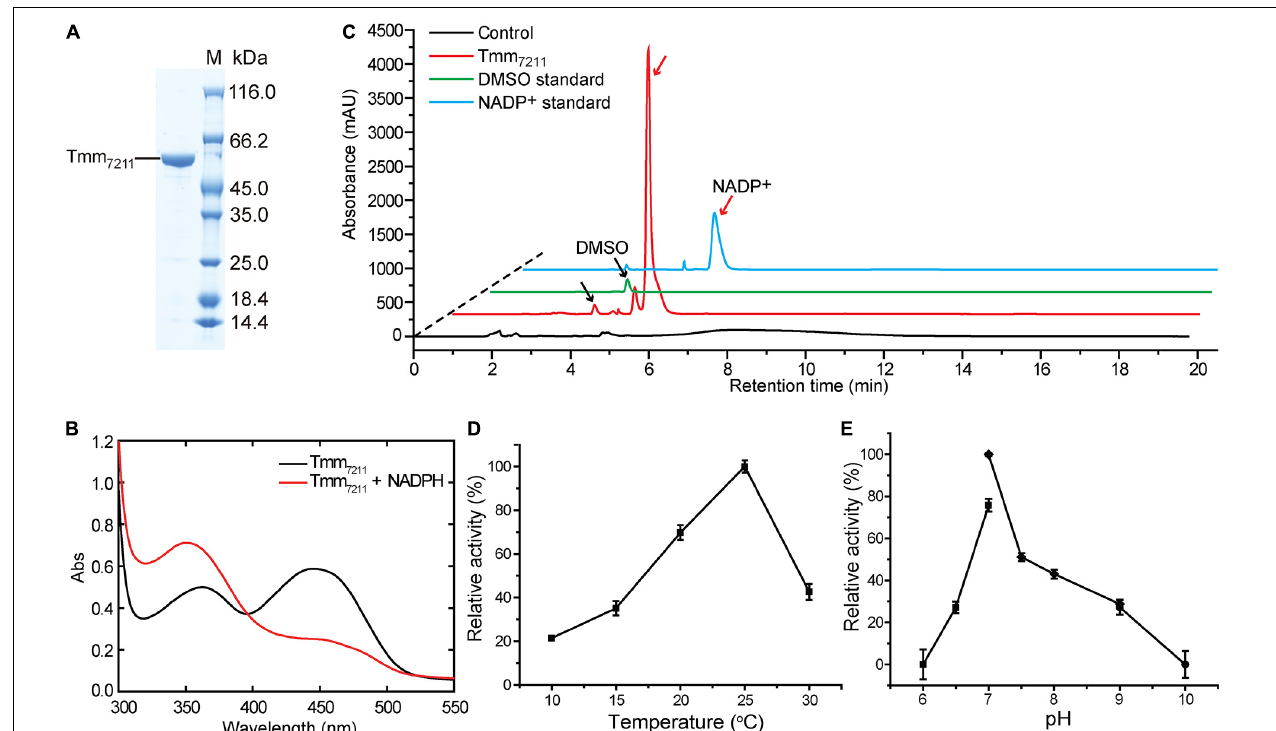
FIGURE 1 | Characterization of Tmm 7211 . (A) SDS-PAGE analysis of the purified Tmm 7211 protein. (B) Absorbance spectra of Tmm 7211 . Black line, the absorbance spectrum of the purified Tmm 7211 . Red line, the absorbance spectrum of the purified Tmm 7211 with the addition of equimolar amount of NADPH (0.1 mM) under aerobic conditions. (C) HPLC assay of the enzymatic activity of the recombinant Tmm 7211 on DMS. The peaks of DMSO and NADP + monitored at 210 nm were indicated with black and red arrows, respectively. The reaction system without Tmm 7211 was used as the control. The DMSO (1.25 mM) and NADP + (0.4 mM) standards were used as positive controls. (D) Effect of temperature on the enzymatic activity of Tmm 7211 . (E) Effect of pH on the enzymatic activity of Tmm 7211 . The optimal pH was examined at 25 ◦ C using Bis-Tris buffer for pH 6–7, Tris buffer for pH 7–9 and glycine buffer for pH 9–10. The standard errors are from three independent